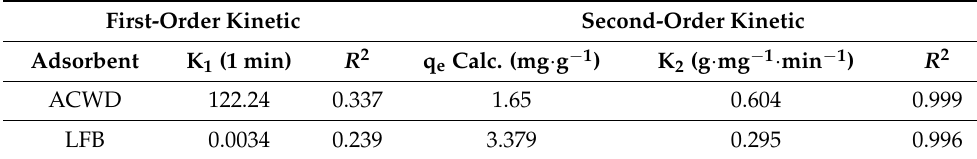
Table 3. The kinetic factors for the removal of ammonium ions by ACDW and LFB.